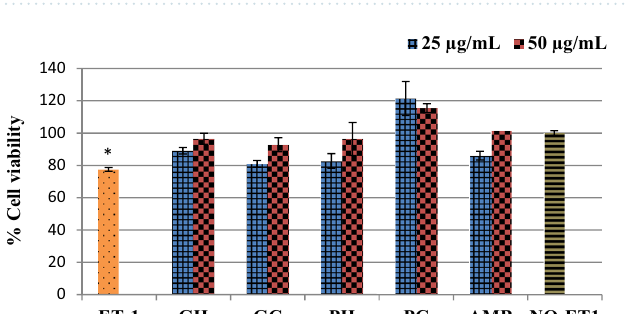
Figure 2. Effects of the hot-water (GH) and cold-water (GC) extracts of P. cubensis and hot-water (PH) and cold-water (PC) extracts of Pan cyanescens mushrooms (50 μg/mL) and positive control ambrisentan (AMB) (25 μg/mL) on cell width size measurements and BNP levels after 48 h treatment, repeated in three different times [*significant].